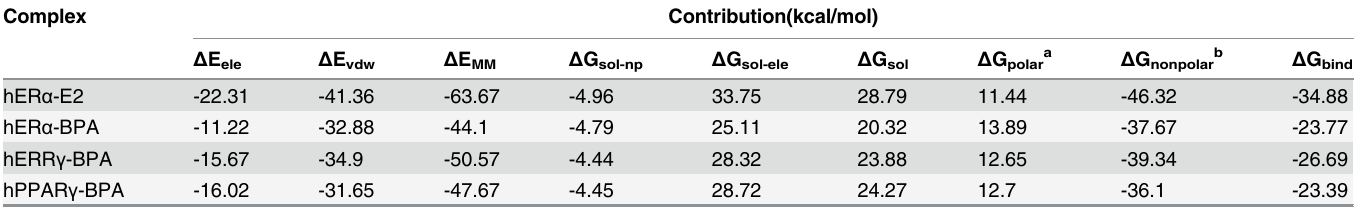
Table 1. Calculated binding free energy and its components based on MM-GBSA method for the four systems. Complex